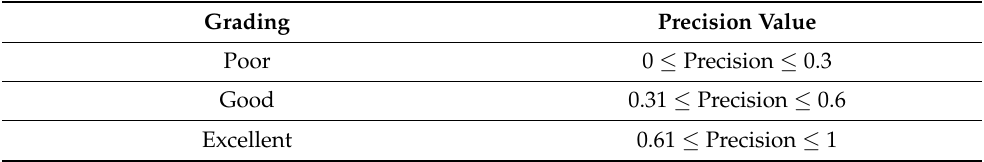
Table 7. Privacy precision grading